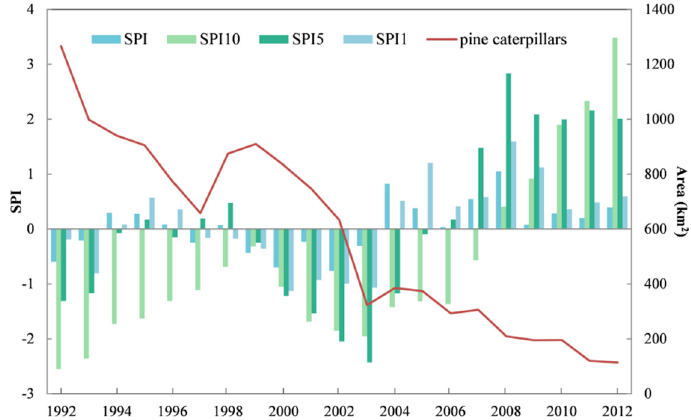
Figure 7. Standard Precipitation Index and pine caterpillar outbreaks in Shandong Province.